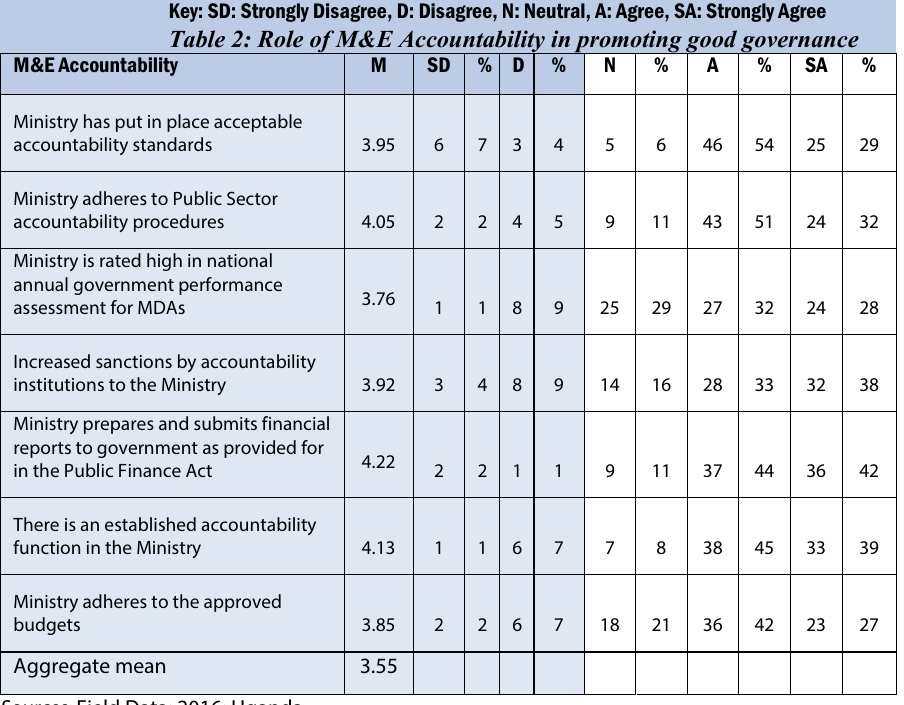
Table 2: Role of M&E Accountability in promoting good